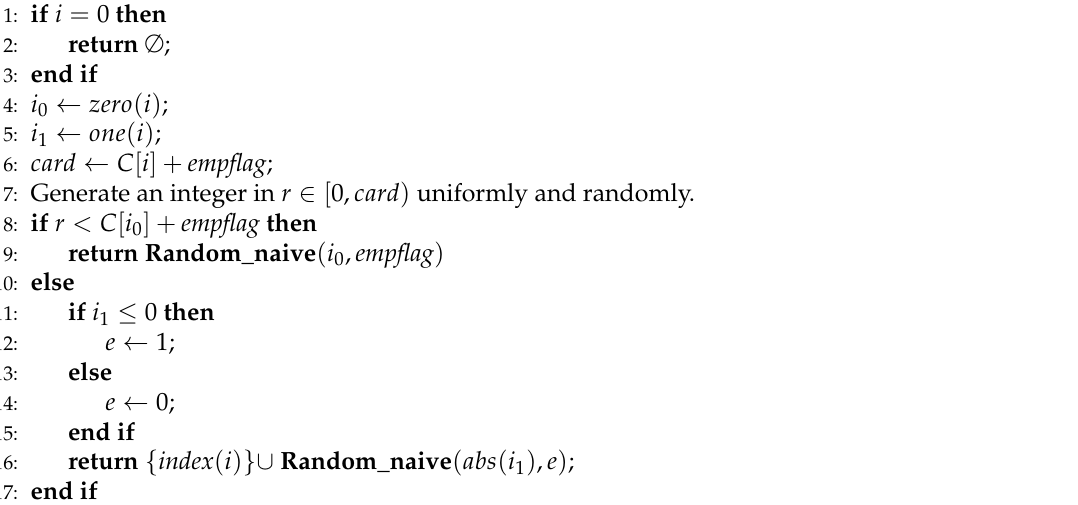
Algorithm 5 Random_naive ( i , empflag ) : Algorithm that returns a set uniformly and randomly chosen from the family of sets that is represented by a ZDD whose root is node i . Assume that Count has already been executed. The argument empflag ∈ { 0, 1 } means whether or not the current family of sets has the empty set. If empflag = 1, this family has the empty